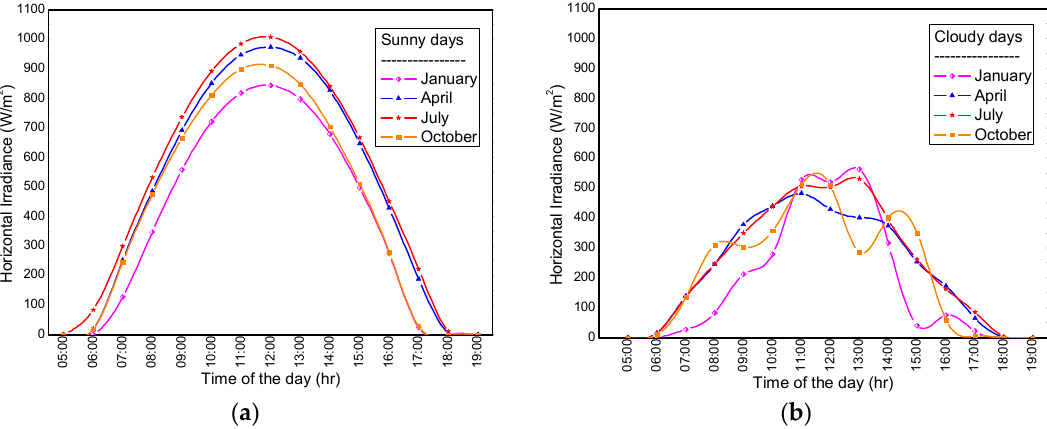
0 4 Figure 11. Annual total irradiation at di ff erent tilted angles for tracked and non-tracked systems. Water 2020 , 12 , x FOR PEER REVIEW Figure 11. A nnual total irradiation at different tilted angles for tracked and non-tracked systems.